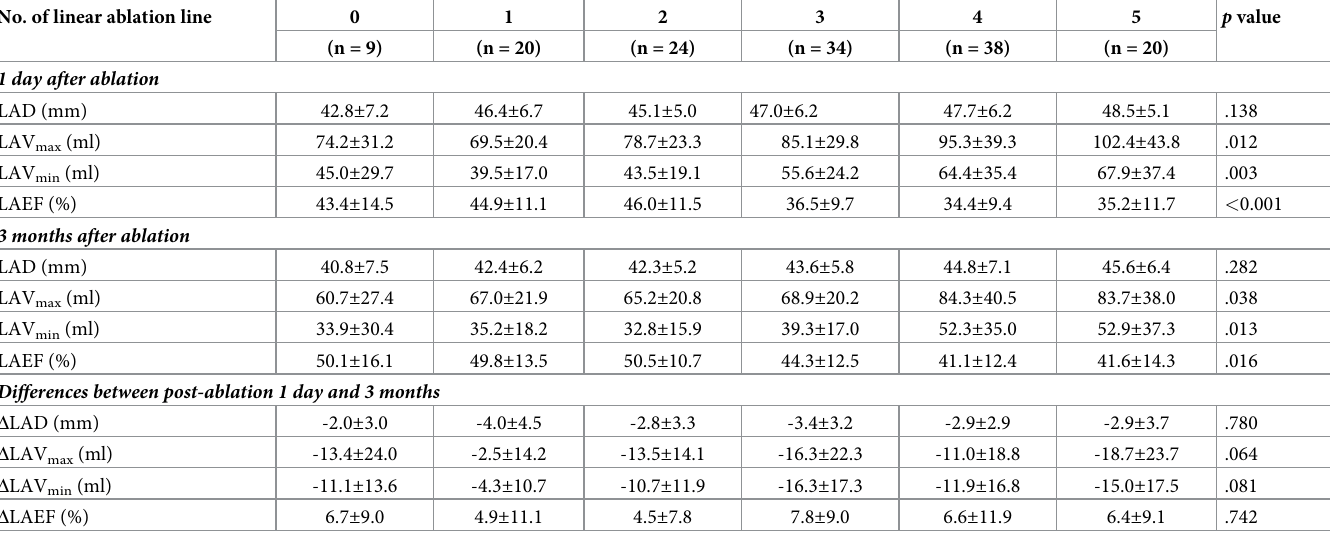
LAD: left atrial diameter; LAV max : maximal left atrial volume; LAV min : minimal left atrial volume; LAEF: left atrial emptying fraction; IVS: intraventricular septum; LVEF: left ventricular ejection fraction; MR: mitral regurgitation. Δ LAD, Δ LAV max , Δ LAV min , and Δ LAEF: differences of LAD, LAV max , LAV min , and LAEF between post-ablation 1 day and 3 months, respectively.